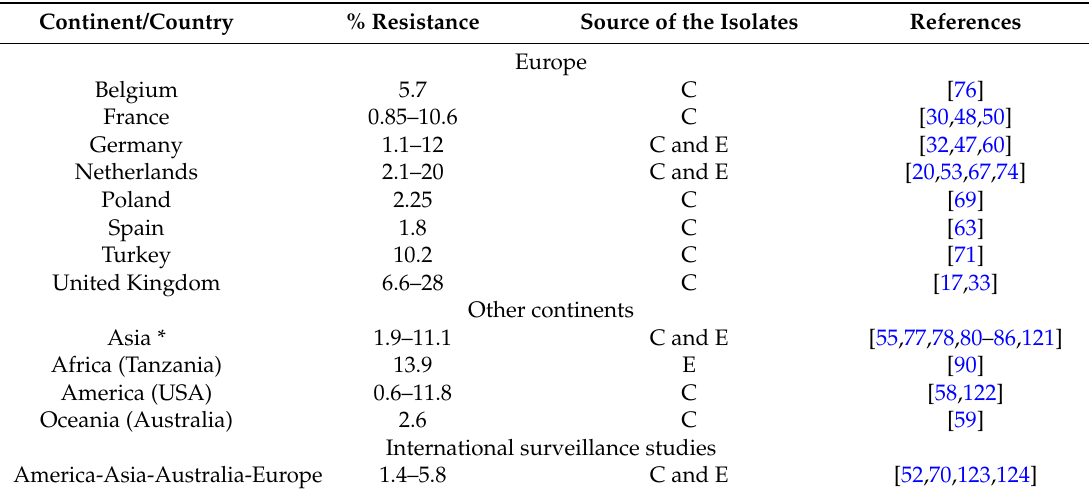
Table 2. Azole resistance prevalence in A. fumigatus by continent and/or country. Only significant publications with more than 50 isolates tested are reported.